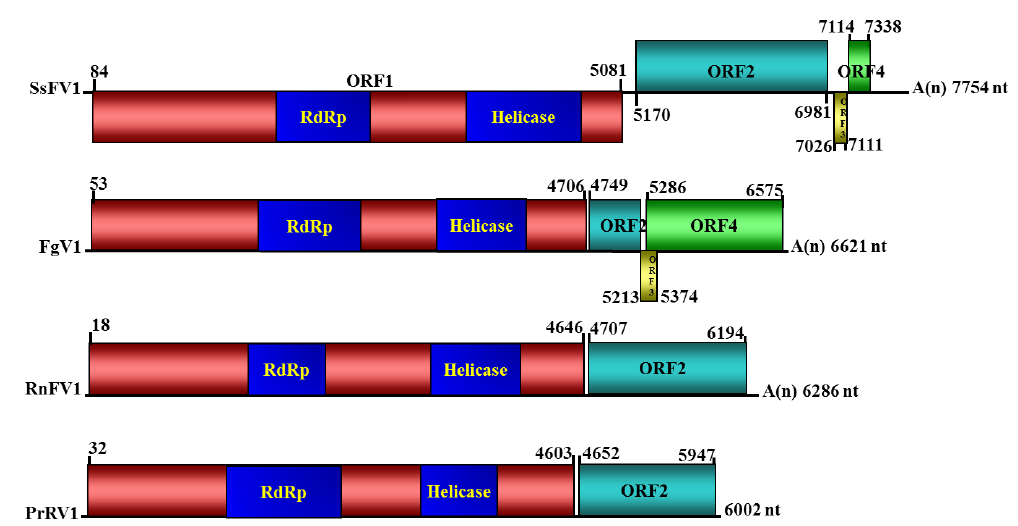
Figure 2. Diagrammatic representation of the putative genomic organization of SsFV1 and related mycoviruses Fusarium graminearum virus-DK21 (FgV1), Rosellinia necatrix fusarivirus 1 (RnFV1), and Penicillium roqueforti RNA mycovirus 1 (PrRV1). Open reading frames (ORFs) are highlighted by shading with different colors. ORFs drawn above and below solid lines refer to different frame for translation. The numbers above solid lines refer to map positions of initiation and termination codons of the respective ORFs. SsFV1 and FgV1 have four putative ORFs, RnFV1 and PrRV1 have two putative ORFs. ‘A(n)’ represents poly(A) structure. The relative positions of the RdRp (RNA-dependent RNA polymerase) and helicase domains in the polyprotein encoded by ORF1 are shaded in blue.